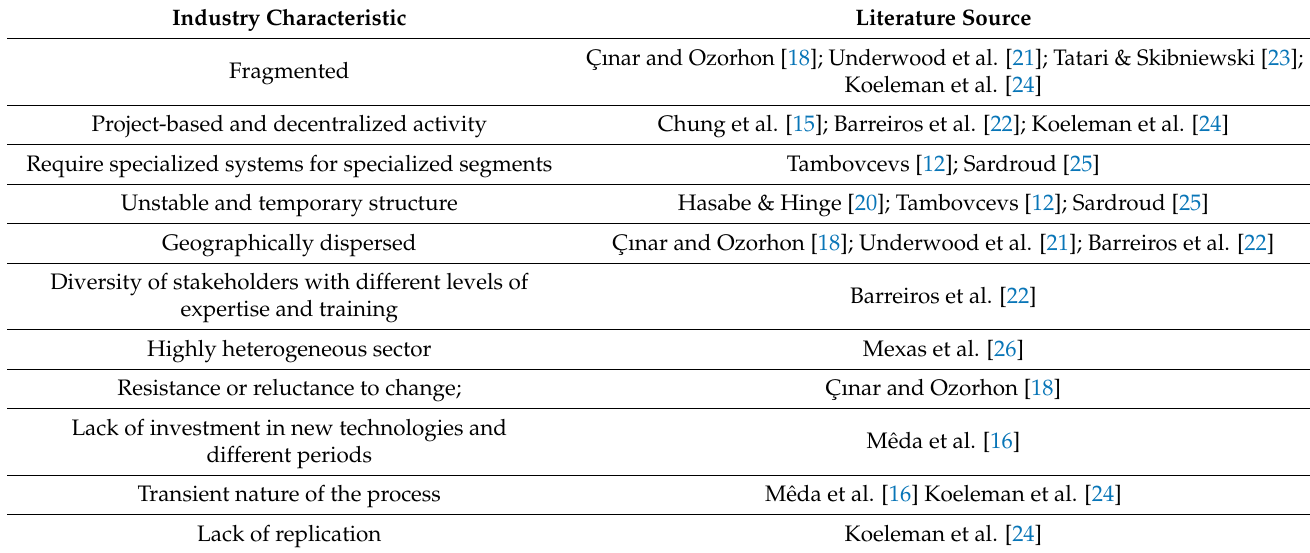
Table 1. Characteristics of the construction industry.